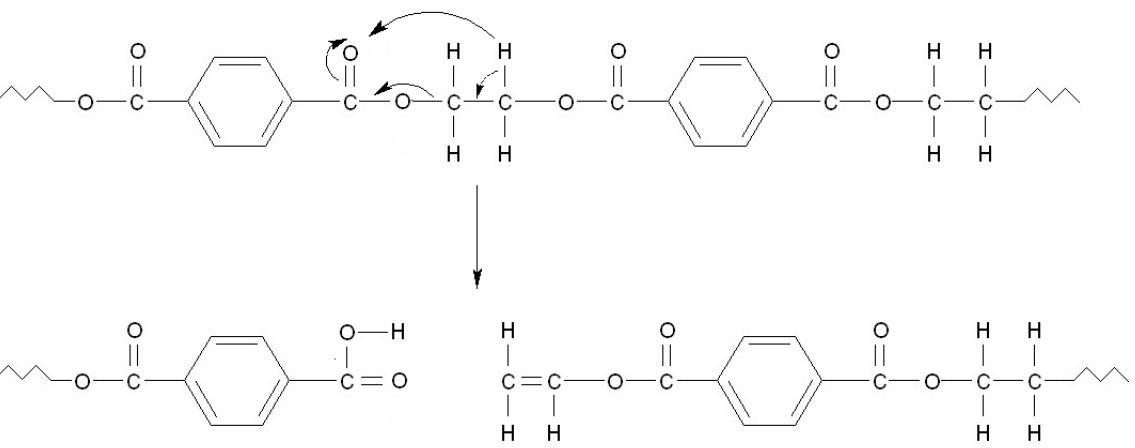
Figure 16. Schematic degeneration of PET by bond breaking at the ethylene element. The following symbols were applied: 9—cleavage of the C-C bond in the ethylene group; 10—formation of a benzoyl radical with a formaldehyde moiety; 11—cleavage of the benzoyl radical with formation of a phenyl radical.